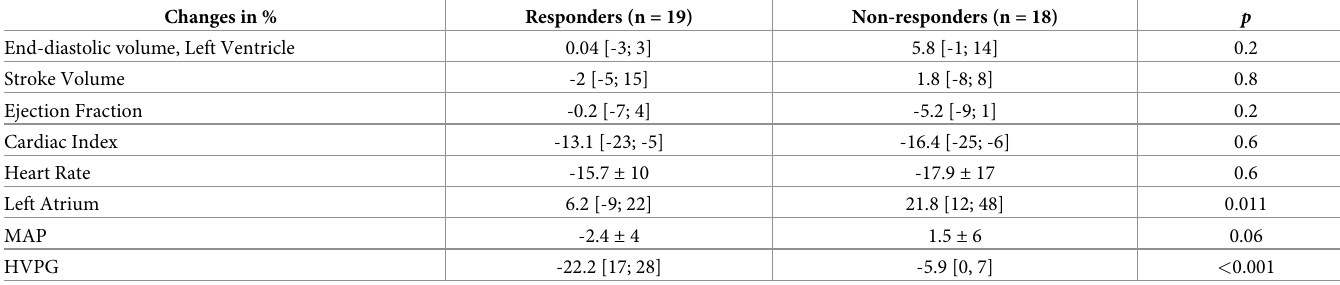
Table 4. Differing impact of NSBB on cardiac parameters in responders vs. non-responders. Changes in